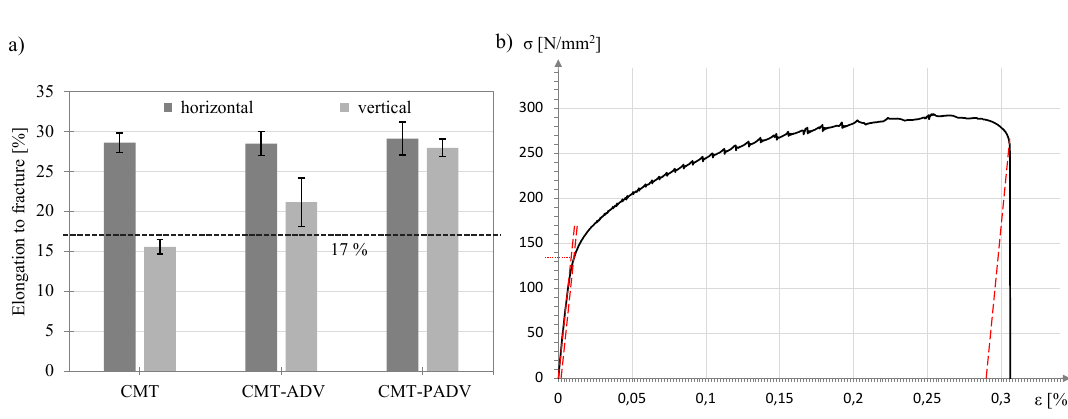
Figure 17. ( a ) Representation of the elongation to fracture of the samples taken vertically and horizontally as a function of the arc mode and the manufacturer’s specification of the elongation to fracture of the pure weld metal (dashed line) and ( b ) the stress–strain diagram for a horizontally taken tensile specimen in the CMT-ADV manufactured structure with dynamic strain ageing.